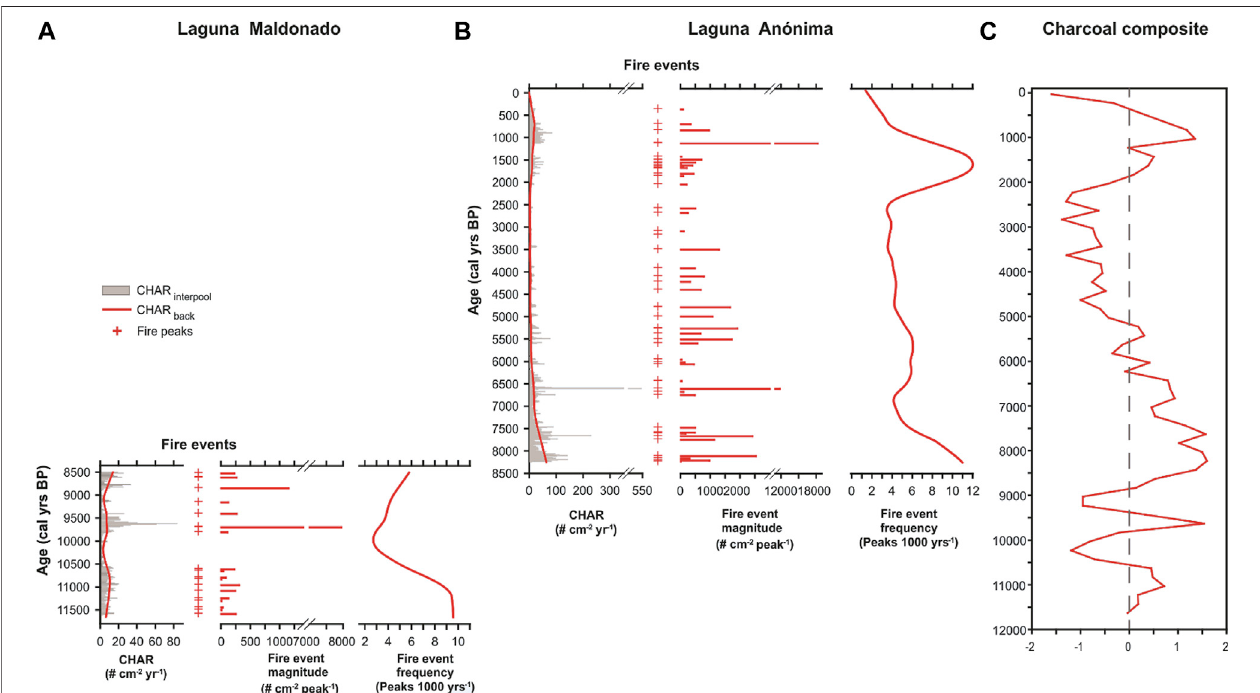
FIGURE5| Charcoalaccumulationrates(CHAR interpol andCHAR back ),inferred fi reevents, fi repeakmagnitudes,and fi reeventfrequencyof (A) LagunaMaldonado and (B) Laguna Anónima. (C) Composite curve ofthecharcoal series ofLaguna MaldonadoandLagunaAnónimarecordssummarizingbiomass burning over time.The gray shadow indicates the 95% con fi dence